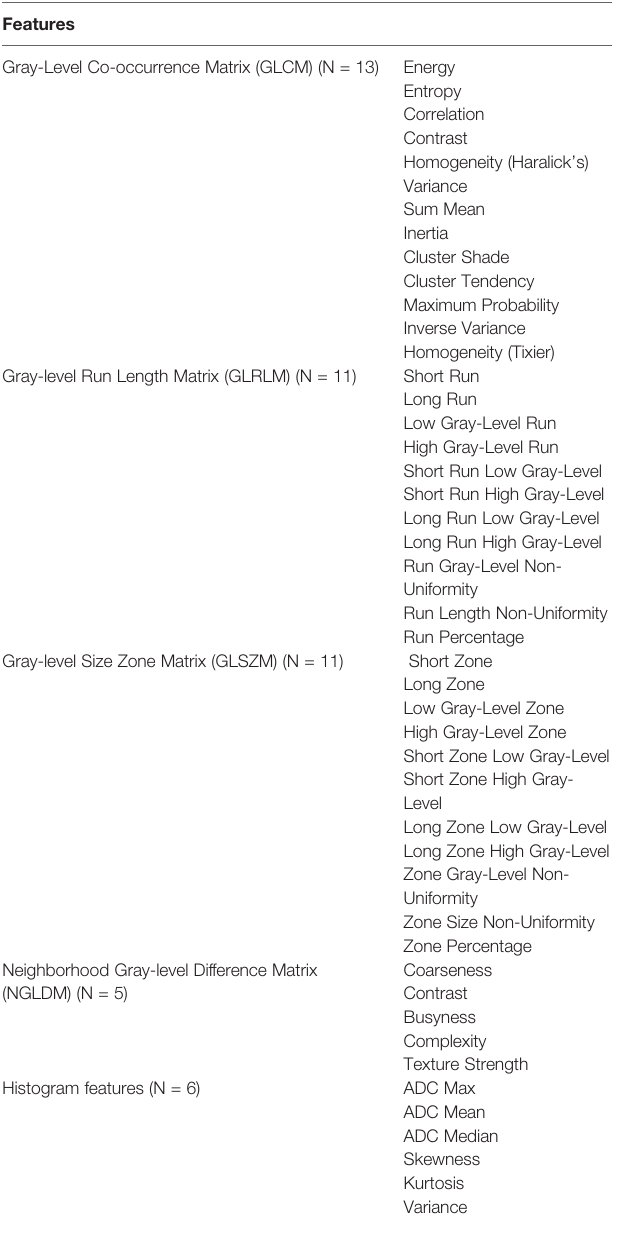
TABLE 1 | List of 46 features (40 texture features and 6 histogram features) investigated for this study.